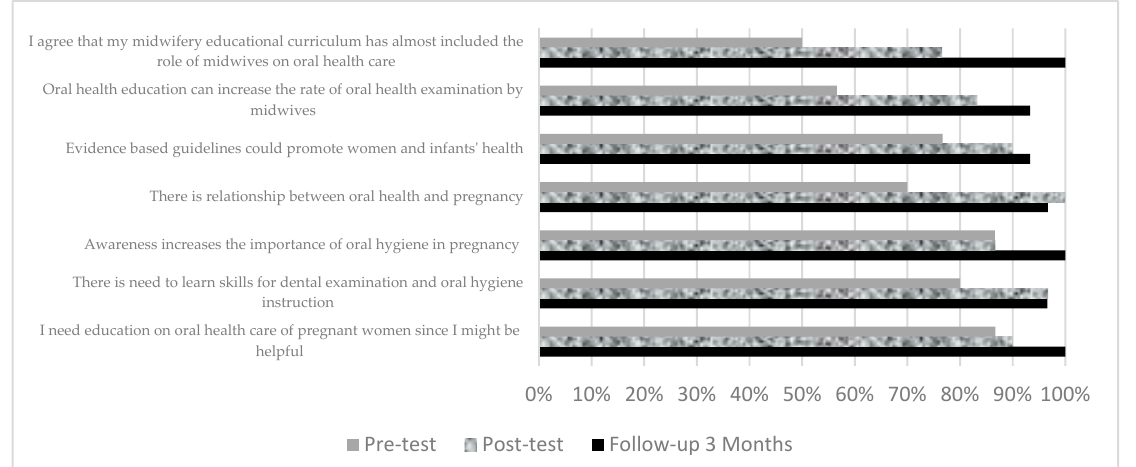
Figure 3. Comparison of positive attitude scores in the intervention group between pre-test, post-test, and follow-up 3 months.